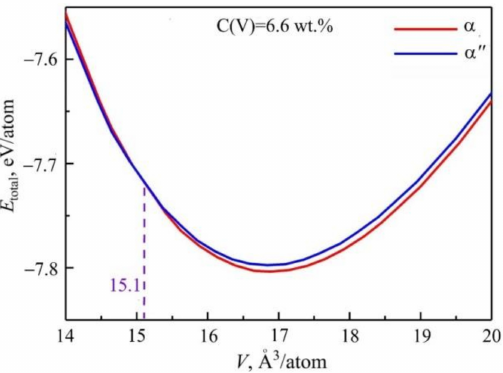
Figure 7. Energy per atom in α - and α ”-Ti with 6.6 wt% of vanadium as a function of atomic